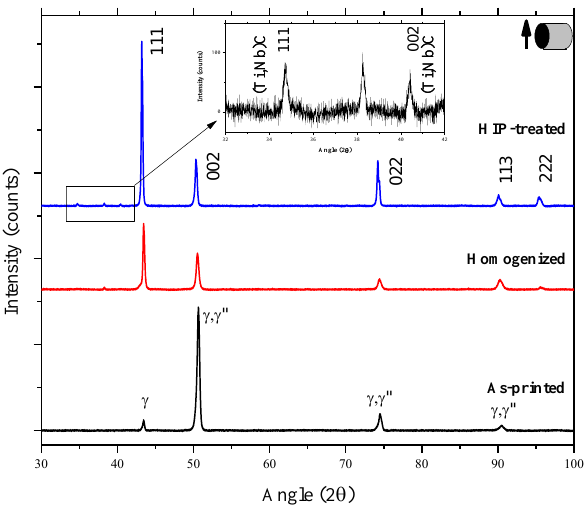
Figure 17. XRD spectra of as-printed, homogenized and HIP-treated specimens scanned in the vertical reference plane.